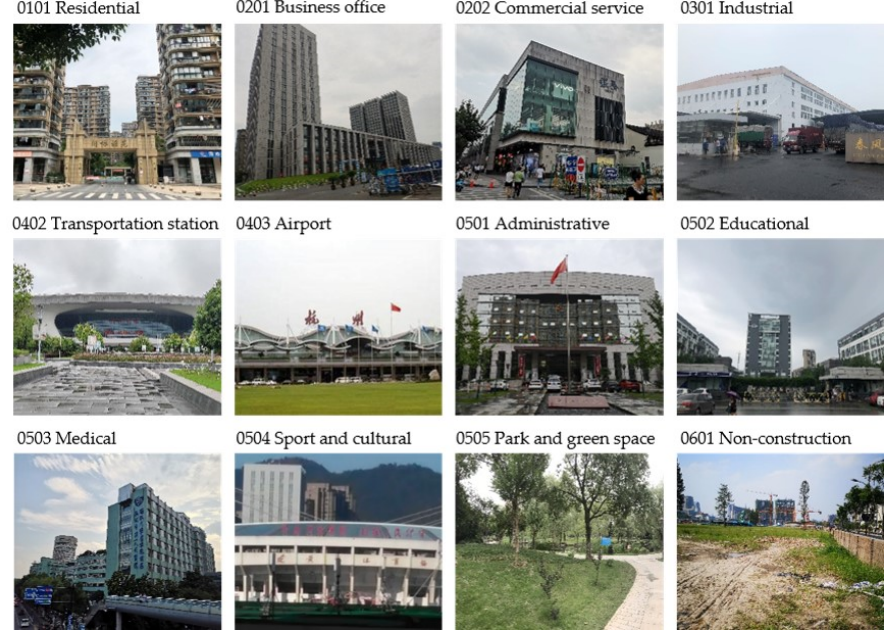
Figure 3. Photos of Level II land-use types collected by field surveys and Google Street Views.